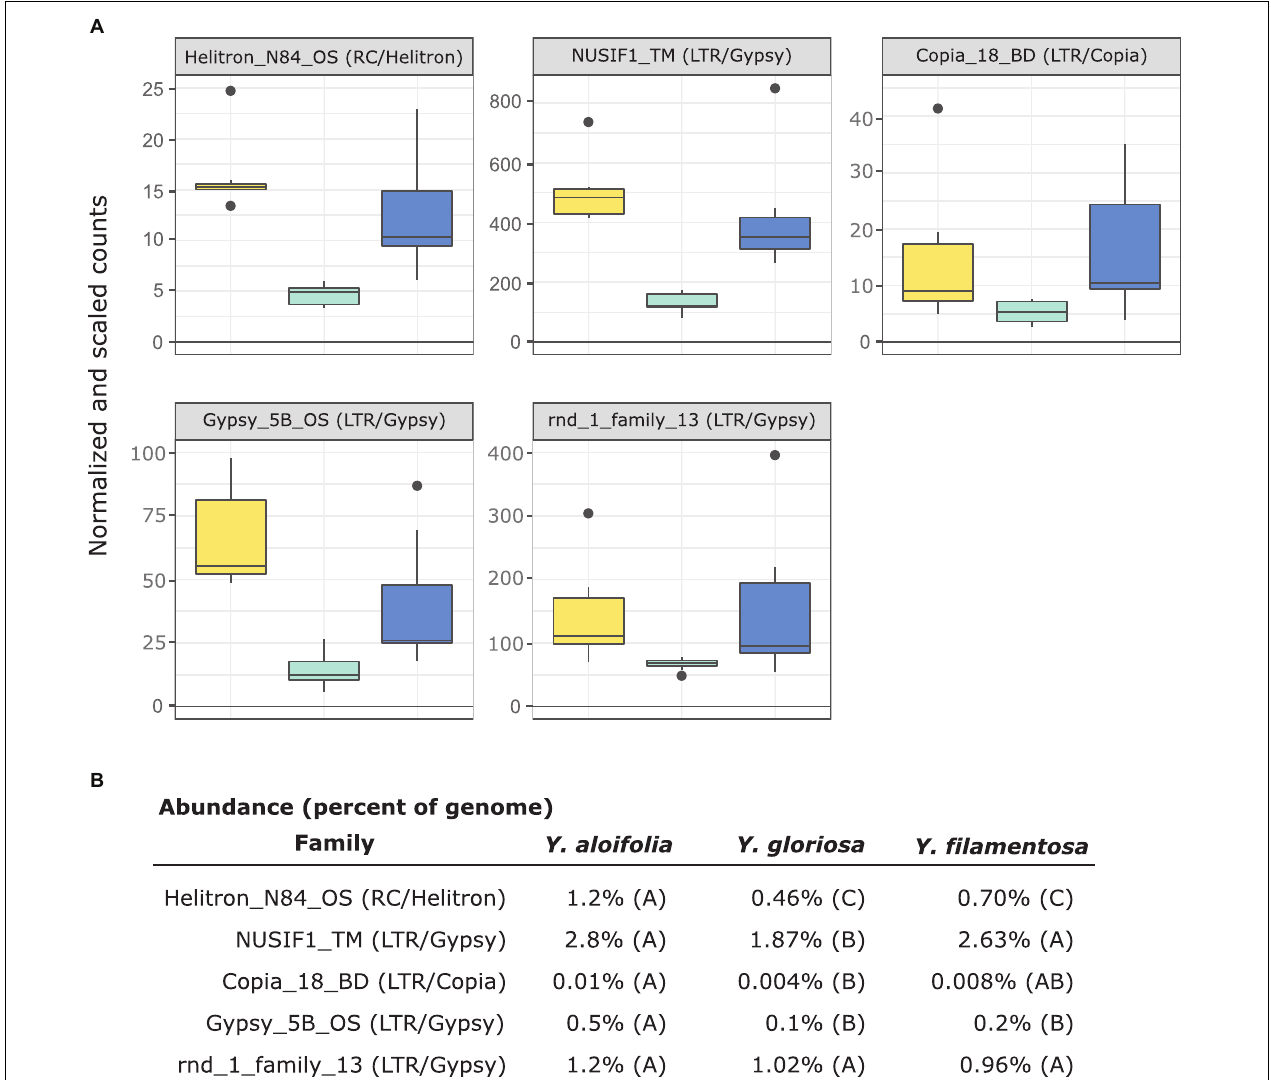
FIGURE 6 | (A) Expression plot of the 5 TE families that were significantly differentially expressed between Y. gloriosa (teal) and both of its parental species ( Y. aloifolia = yellow, Y. filamentosa = blue). TMM-normalized count data that is further scaled by abundance is plotted. (B) Mean percent abundance per species, as estimated by Transposome, and the result of post hoc test using emmeans() in R on the results of a negative binomial generalized linear model. Shared letters indicate no significant difference at a p <